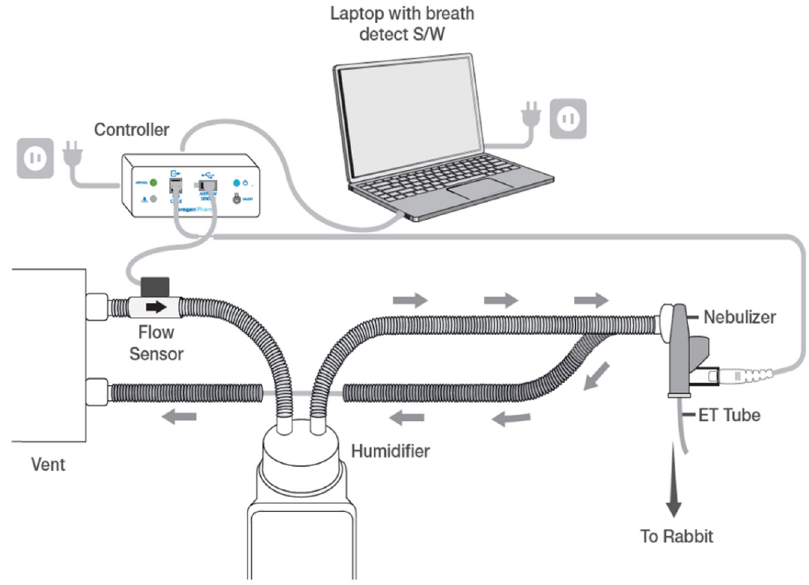
Figure 2. Nebulizer system. Schematic of the surfactant delivery system used for animals. This nebulizer produces aerosol with a novel, two-layer vibrating mesh aperture plate and prevents drug loss to the system on exhalation by synchronizing drug delivery to a ventilator breath by means of a flow change sensor placed within the inspiratory limb of the ventilator circuit to detect inspirations and provide signal to a controller. Controller sends signal to vibrating mesh nebulizer placed between vent circuit and endotracheal tube to emit aerosol for the first 80% of each breath. (Schematic provided courtesy of Aerogen Pharma).